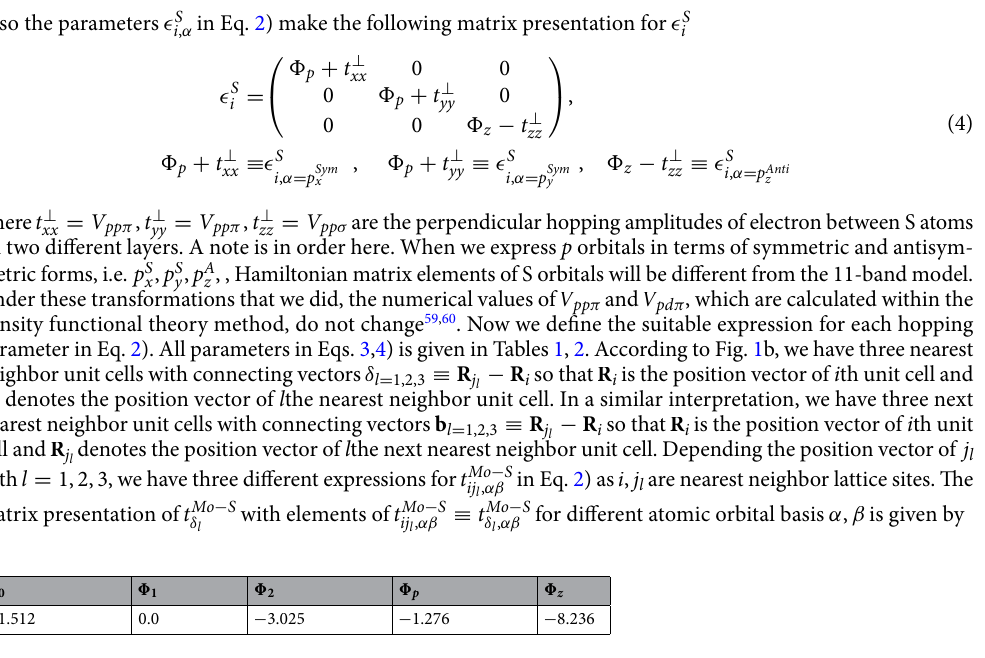
Table 1. On-site energy parameter values in Eqs. (3, 4) for monolayer MoS 2 . All terms are in units of eV.